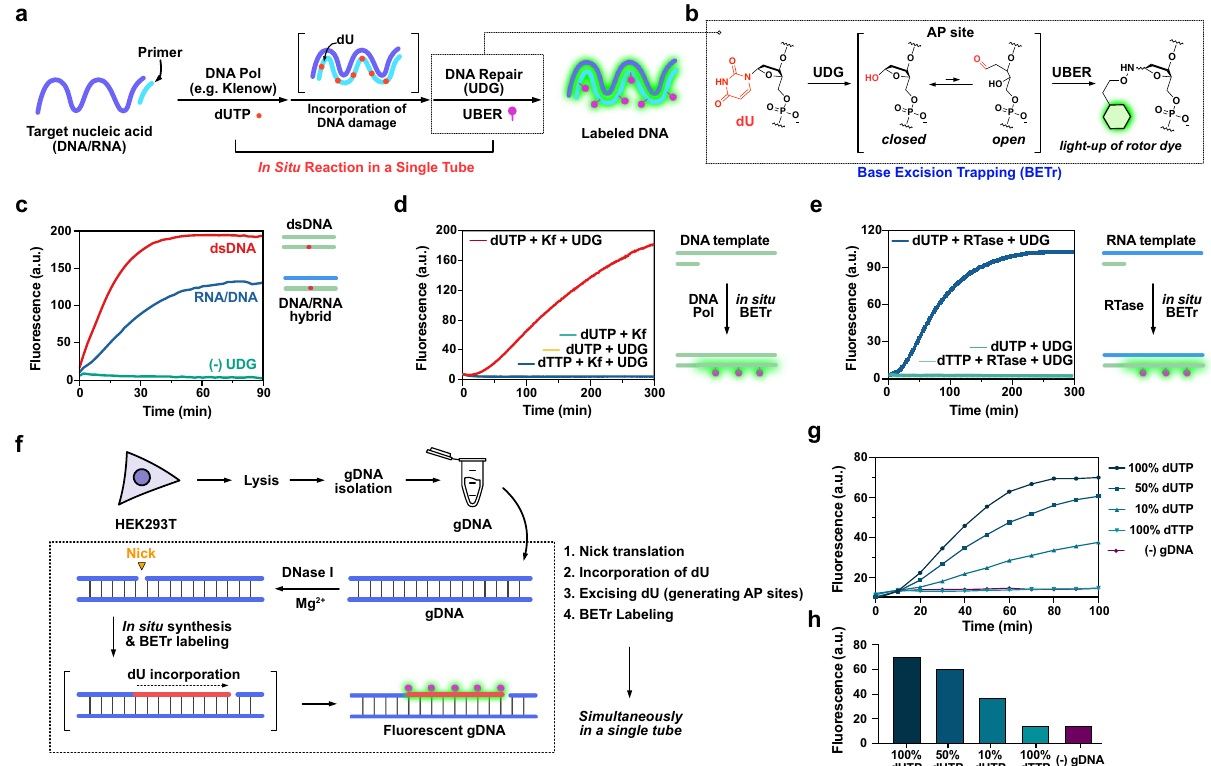
Fig. 1 | In situ DNA synthesis and BETr labeling. a Illustration of the incor- poration of deaminated bases during DNA synthesis followed by DNA repair and labeling by UBER. b Mechanism of Base Excision Trapping (BETr). c Fluorescence intensity changes upon BETr labeling in dsDNA (DNA_dU/DNA, 400nM) and DNA/RNA hybrid (DNA_dU/RNA, 400nM). d Fluorescence inten- sity changes of in situ DNA synthesis and BETr process with 2U/mL Klenow (exo-). e Fluorescence intensity changes of in situ reverse transcription and BETr labeling with 2 U/ µ L Revert Aid H Minus RT. f Illustration of in situ BETr labelingofgDNAthroughnicktranslation. g Fluorescenceenhancementduring